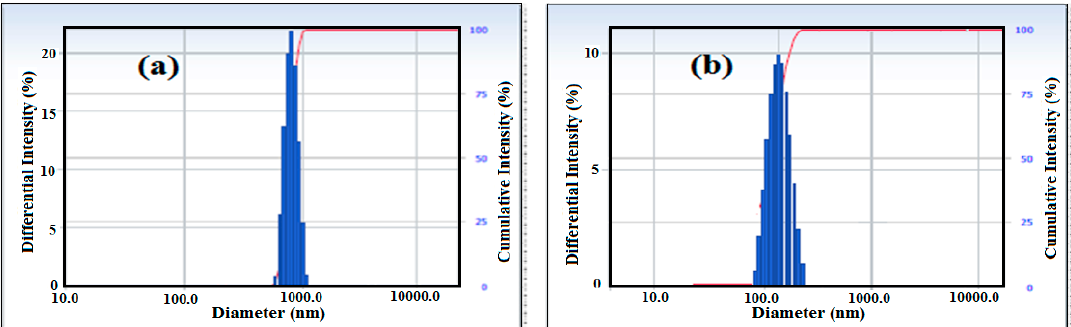
Figure 5. DLS data in n -heptane of ( a ) HSNP-1 and ( b ) HSNP-2.